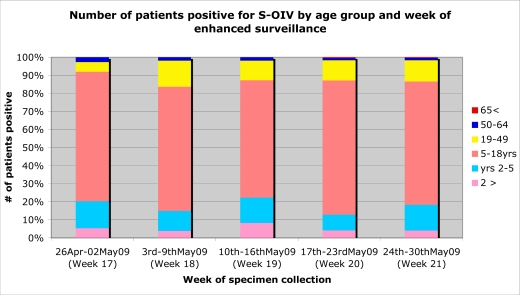
Age distribution of S-OIV positive patients by week of enhanced surveillance.